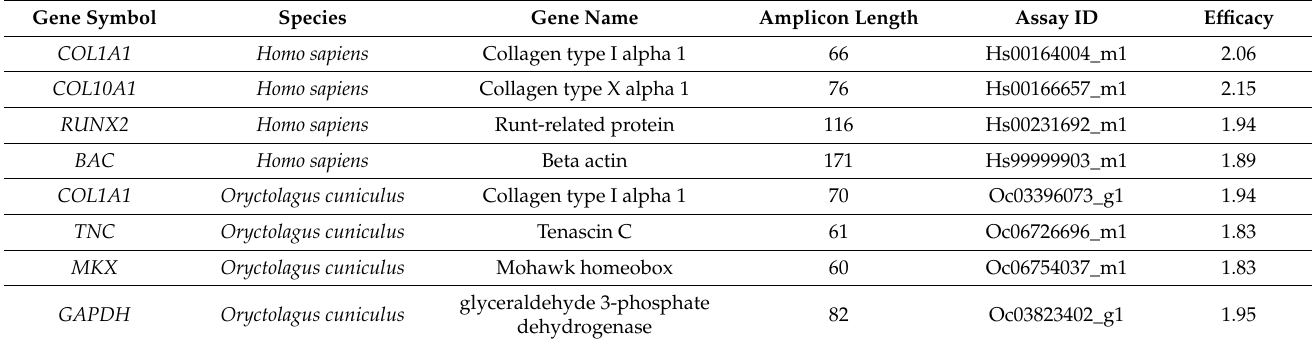
Table 2. Primer list for gene expression